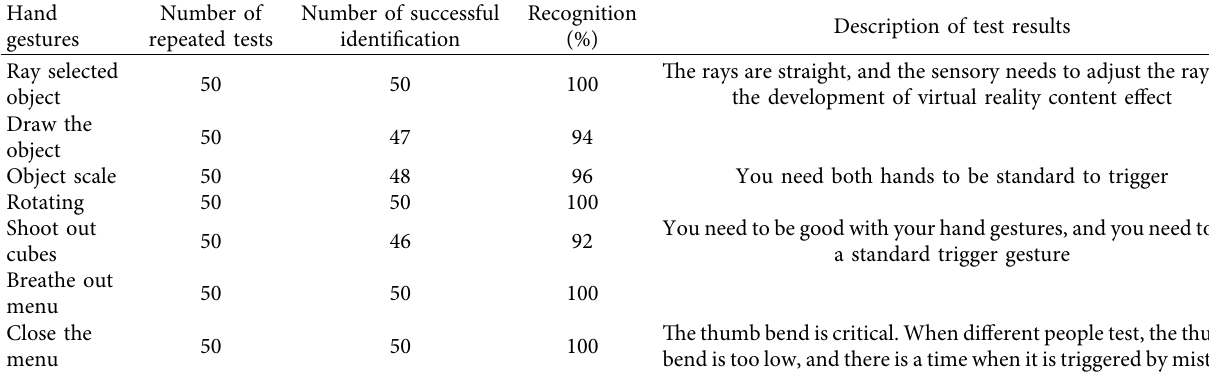
Table 1: Test results of virtual reality gesture